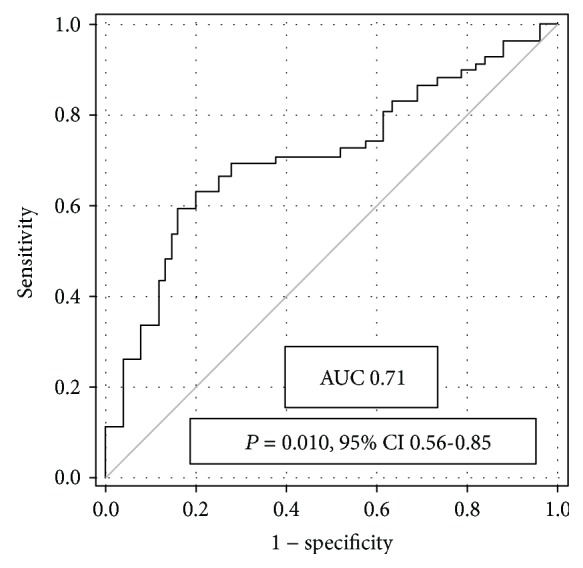
ROC curve analysis of the anti-GlcNAcβ IgG level in HCV-1b carriers with stages F0 and F1–4.